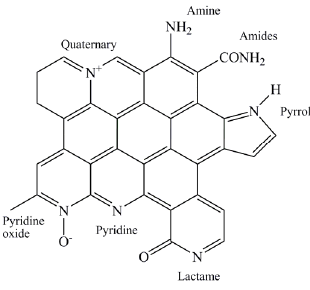
Figure 1. Different N ‐ containing groups possibly present in carbons.